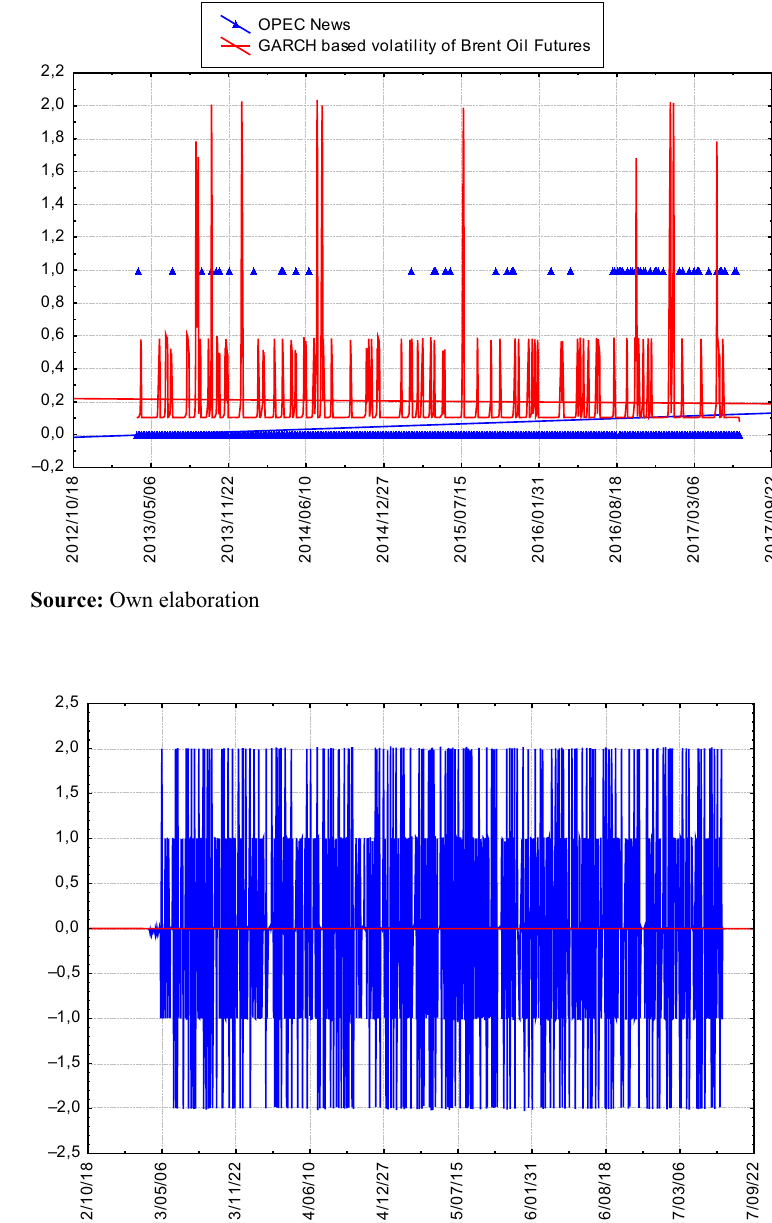
Figure 7. The return of the London gas oil futures over the period from April